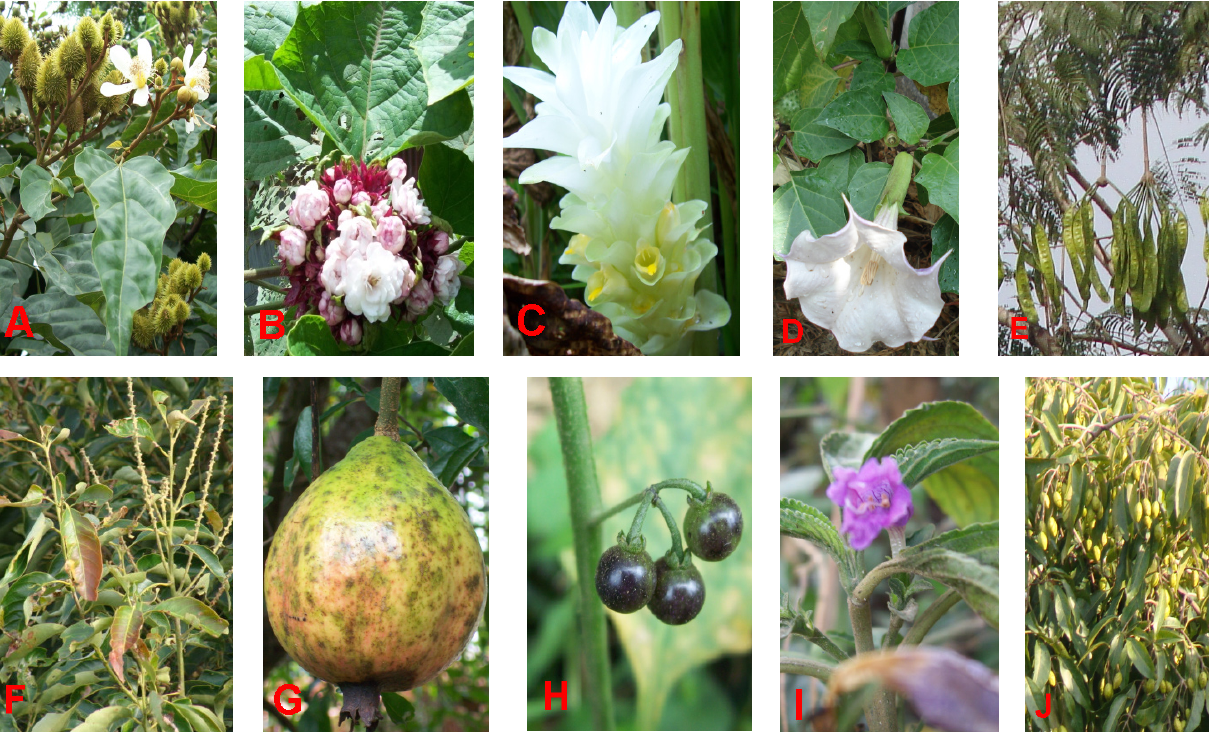
Fig. 1. Photographs of the dye yielding plants. (A) Bixa orellana , (B) Clerodendrum chinense , (C) Curcuma domestica , (D) Datura stramonium , (E) Parkia timoriana , (F) Lithocarpus pachyphylla , (G) Punica granatum , (H) Solanum nigrum , (I) Strobilanthes flac- cidifolius and (J) Terminalia